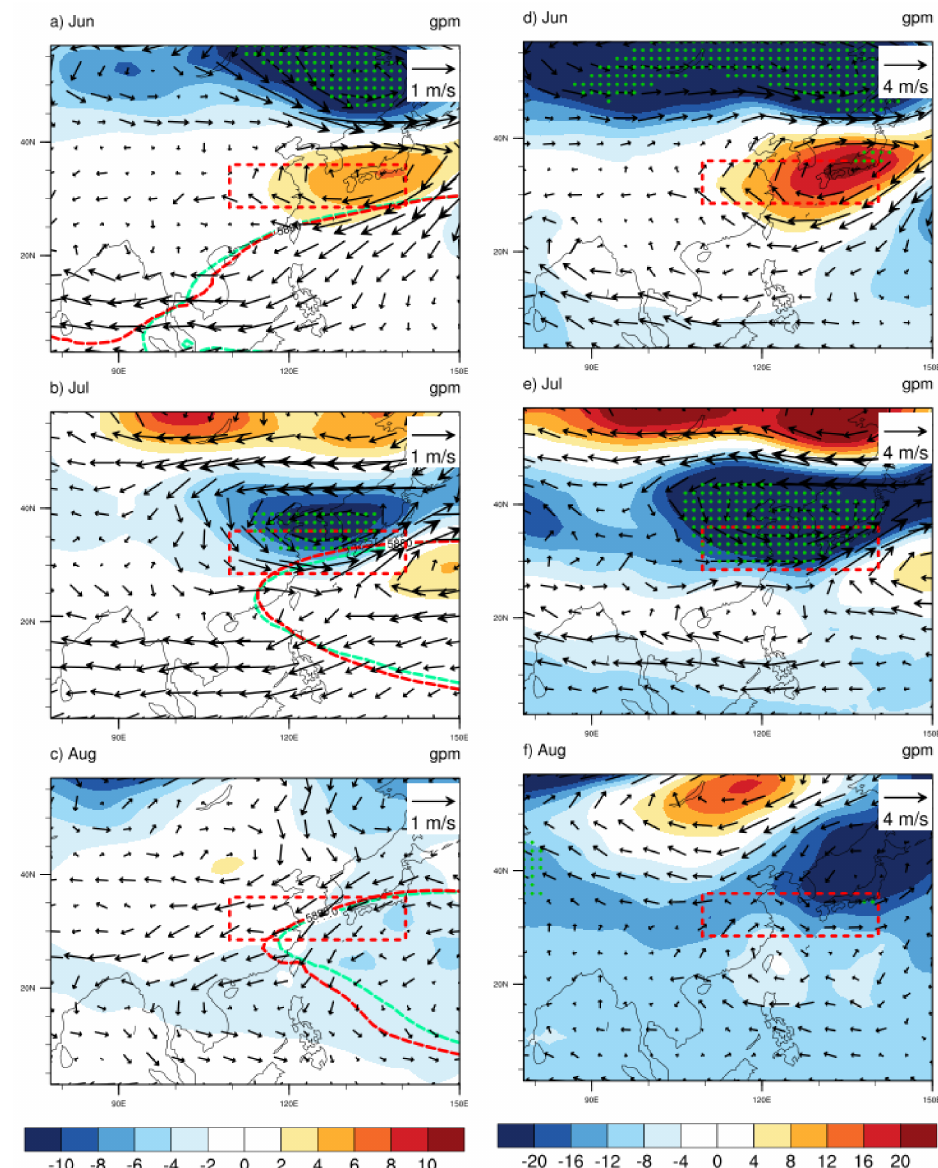
Figure 8. Same as Figure 5 but for PC2. Regression maps are ( a – c ) and difference maps are ( d – f